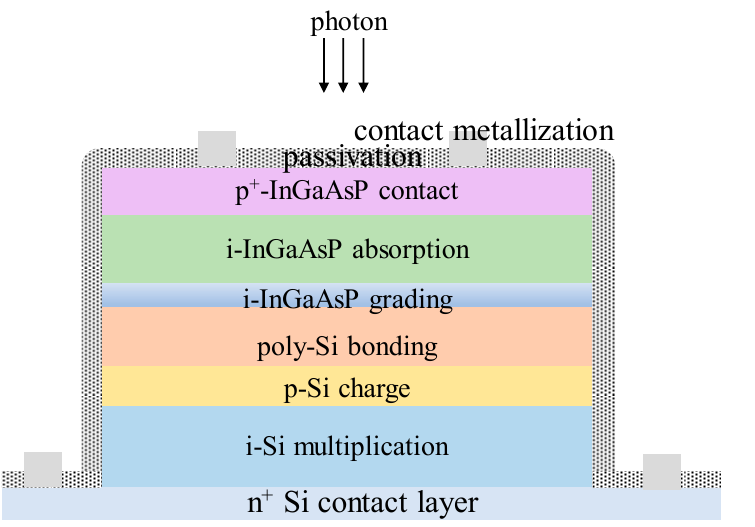
Figure 57. Wafer-bonded InGaAs/Si SAGCM APDs